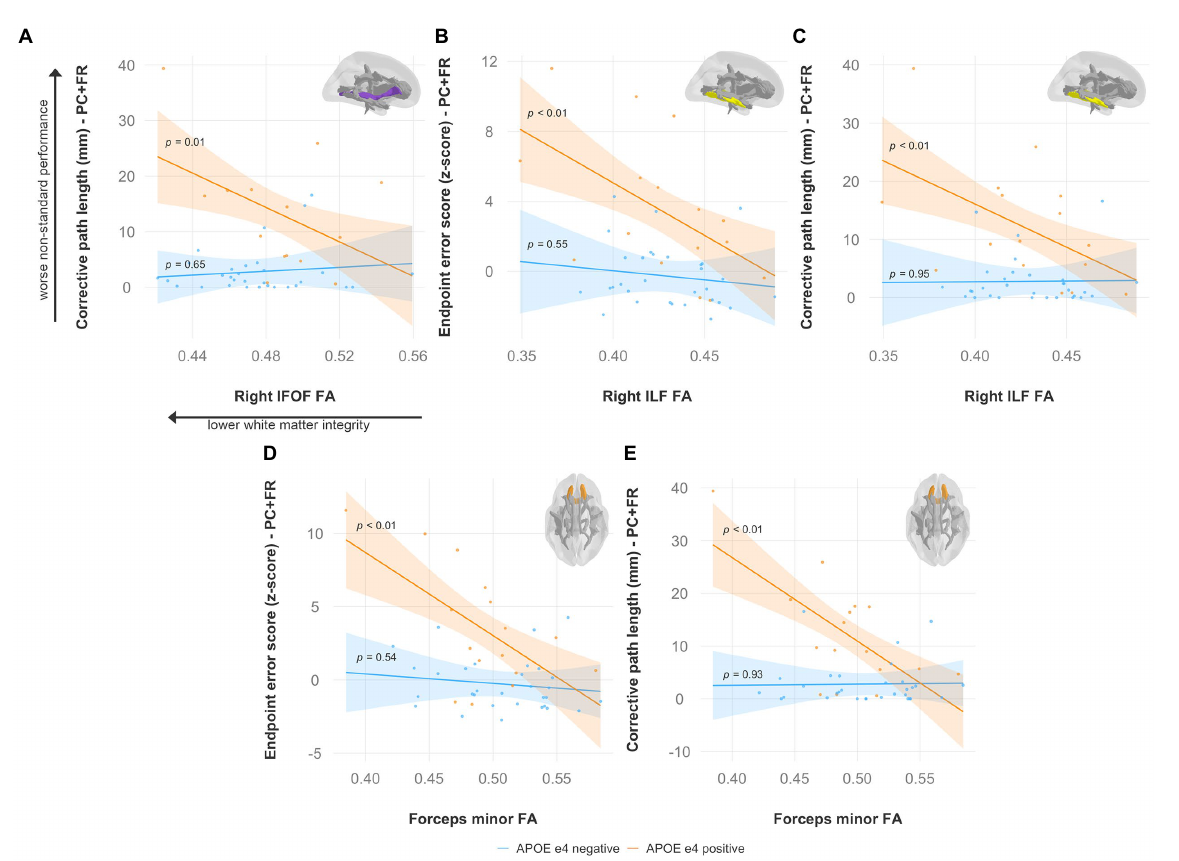
FIGURE 6 Lower fractional anisotropy predicts worse visuomotor performance (reflected by higher endpoint error scores or corrective path lengths) in the plane-change feedback reversal condition only in APOE e4 carriers in several major white matter tracts, including the (A) right IFOF, (B,C) right ILF, and (D,E) forceps minor. Significant results shown from multiple regression and simple slopes analyses. Brain figures made with “ggseg” R package (Mowinckel and Vidal-Piñeiro, 2020). PC + FR, plane change feedback reversal condition; APOE, apolipoprotein E; FA, fractional anisotropy; IFOF, inferior fronto-occipital fasciculus; ILF, inferior longitudinal